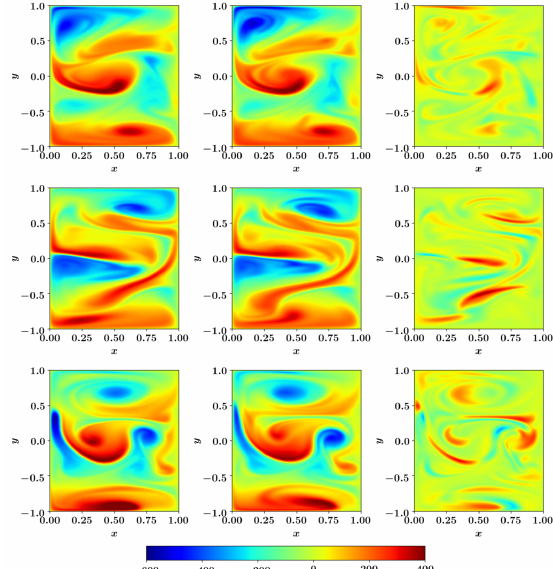
Figure 14. Snapshots of the true vorticity field ( left ), analysis estimate of the DEnKF algorithm ( middle ), and the difference (error) between the two fields ( right ) obtained for a particular run of the single-layer QG model. The snapshots of vorticity field are plotted at t = 0.3, 0.35, 0.4 (from top to